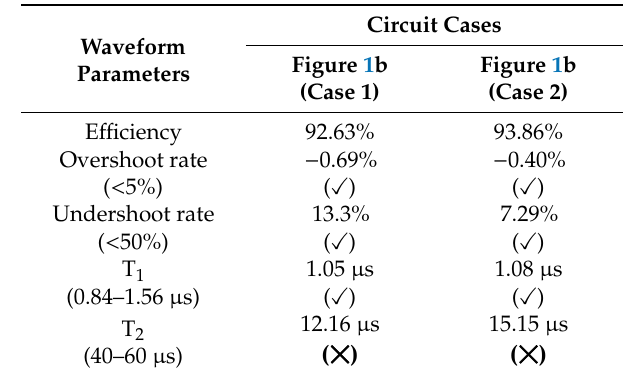
Figure 2. Generated waveforms using the conventional circuit. Table 1. Circuit parameters in the conventional lightning impulse voltage generation circuits and waveforms parameters of the generated waveforms.